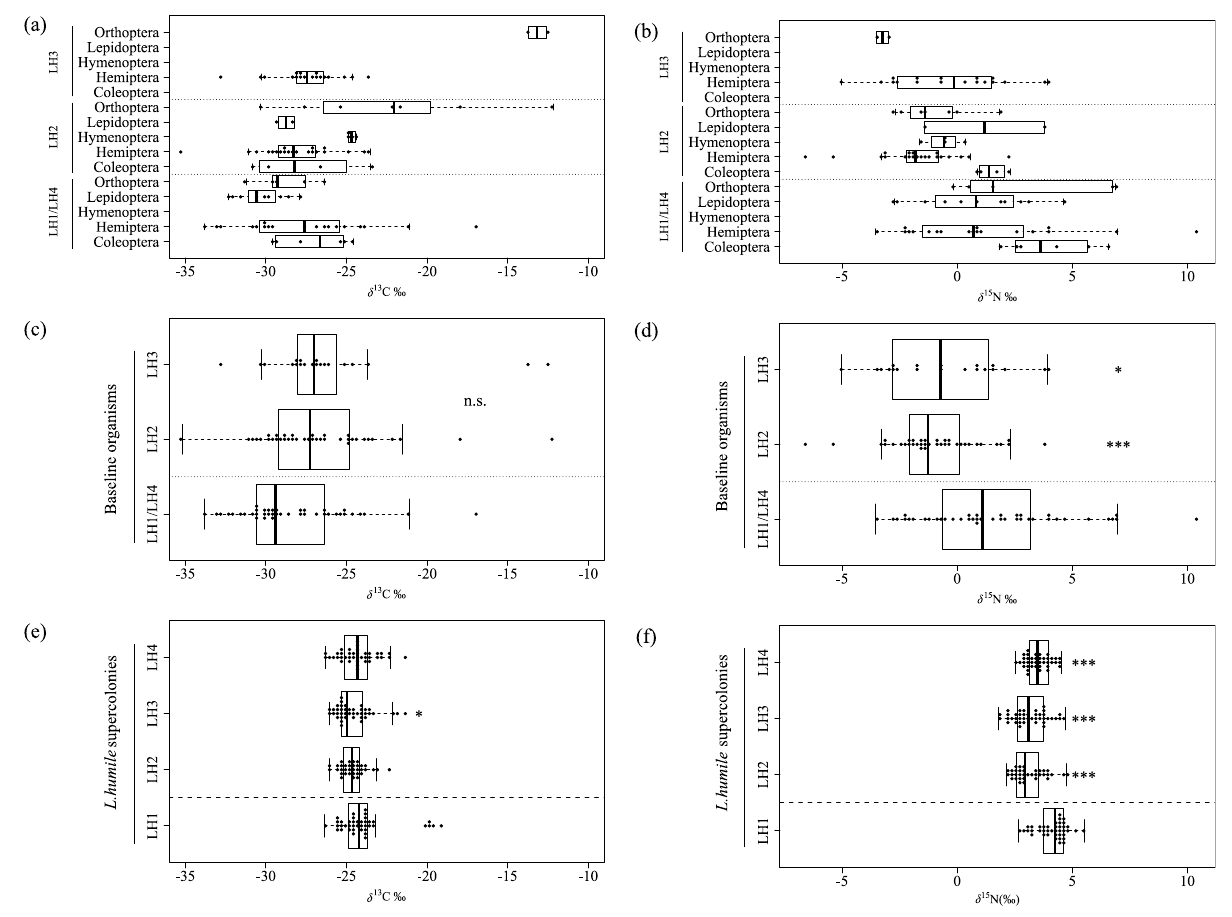
Figure 2. Comparisons of δ 13 C values of baseline organisms (arthropods) within the same sampling site of supercolonies LH1 and LH4 of L. humile and within sampling sites of other supercolonies (LH2, LH3) at the ( a ) taxonomic group and ( c ) community levels. The δ 15 N values of baseline organisms at taxonomic group and community levels within each L. humile sampling site are shown in ( b ) and ( d ), respectively. Comparisons of δ 13 C and δ 15 N among the four Japanese L. humile supercolonies are shown in ( e ) and ( f ), respectively. Differences in the δ 13 C and δ 15 N of baseline organisms at the community level among sampling sites ( c , d ) and of the four L. humile supercolonies ( e , f ) were analysed by Mann–Whitney U test. Asterisks (* p < 0.05, ** p < 0.01, *** p < 0.001) denote significant